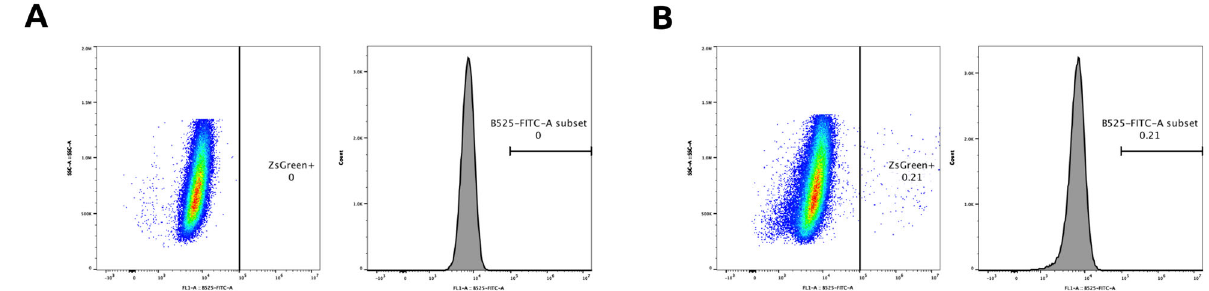
Fig. 5 Flow cytometry gating strategy. a Negative control to establish ZsGreen + gate. b Evaluation of gate on cell samples expressing